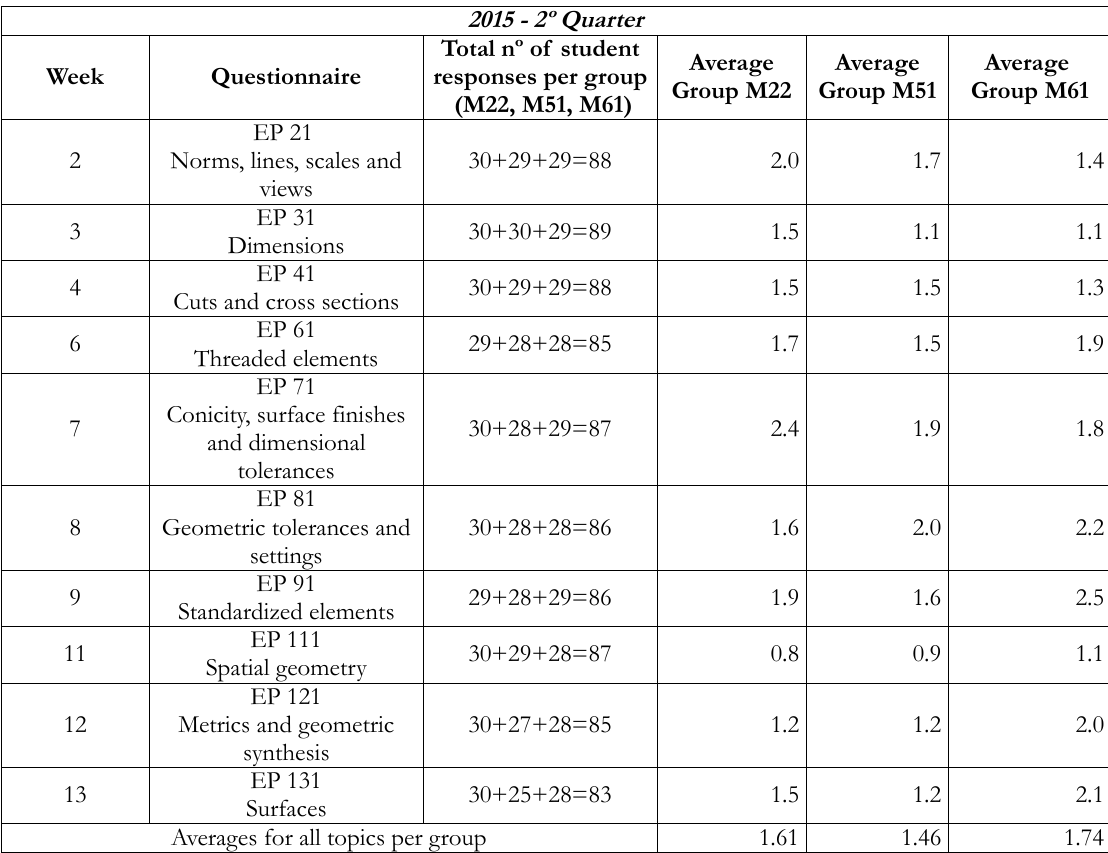
Table 2. Group assessment averages. 3 is the highest